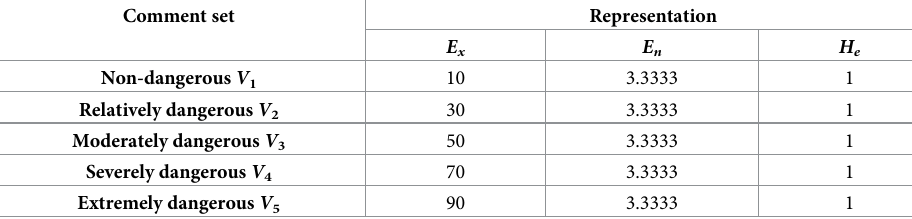
Table 2. The number of standard cloud model features corresponding to the comment